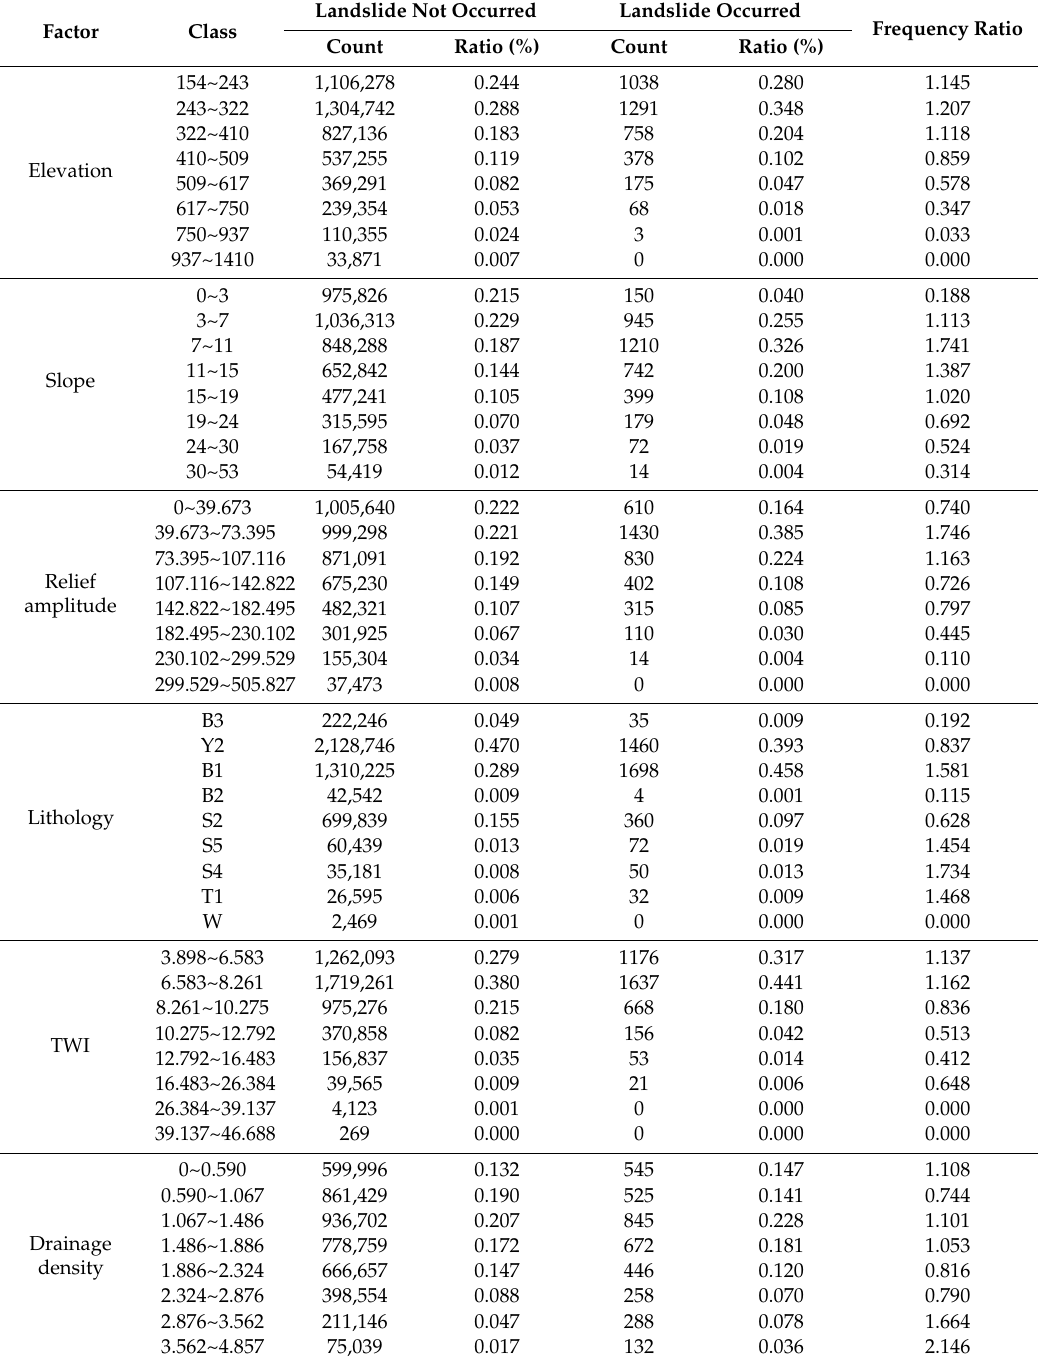
Table 2. Frequency ratios (FRs) of conditioning factors (aspect, plane curvature, profile curvature, NDVI are not